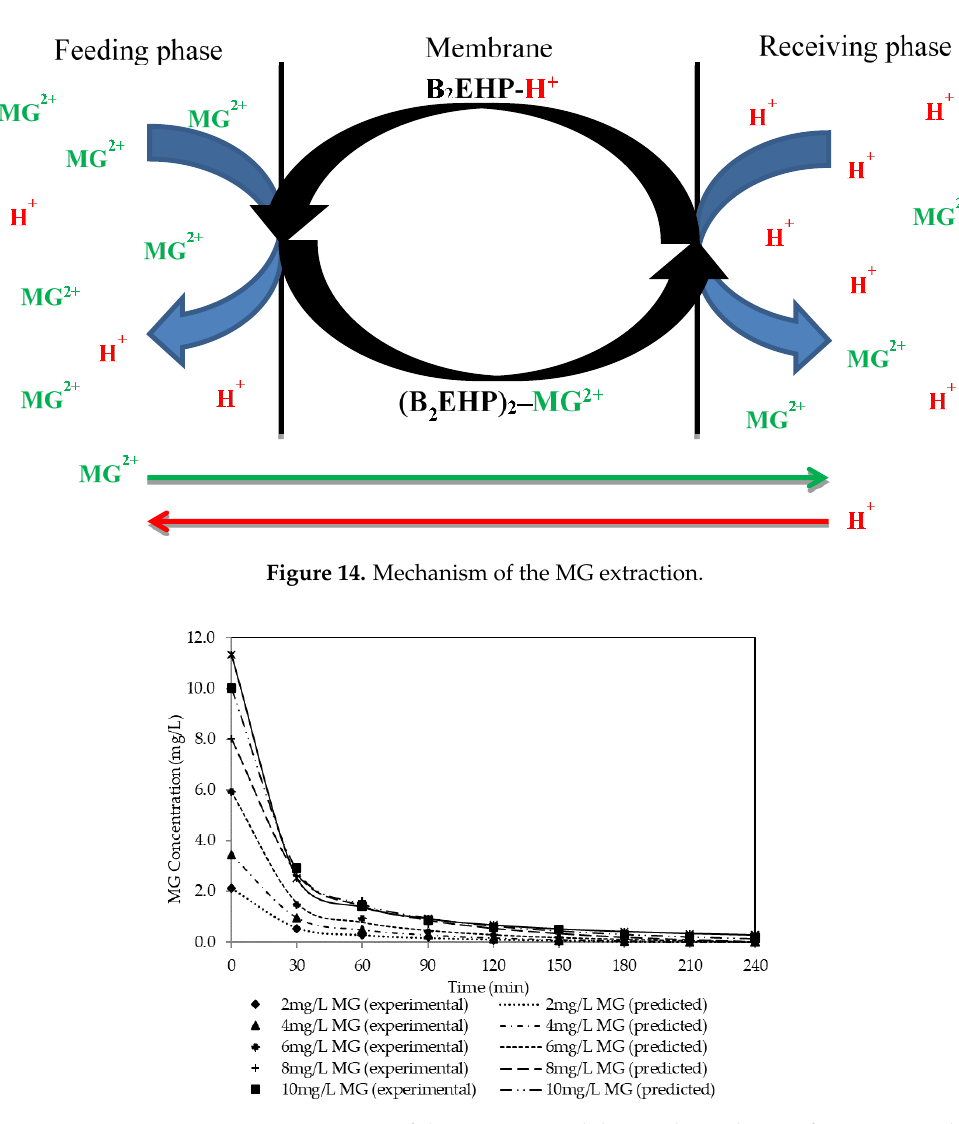
Figure 15. Comparison of the experimental data and simulations from PSO models at different dye concentrations.